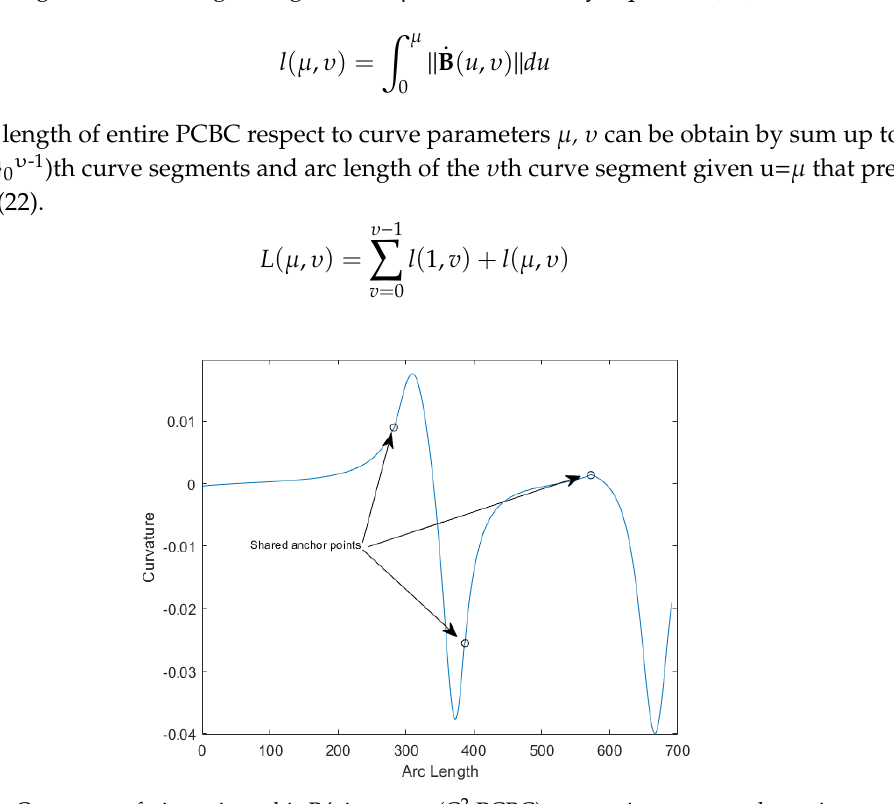
Figure 6. Curvature of piecewise cubic Bézier curve (C 2 PCBC) are continuous over the entire curve.